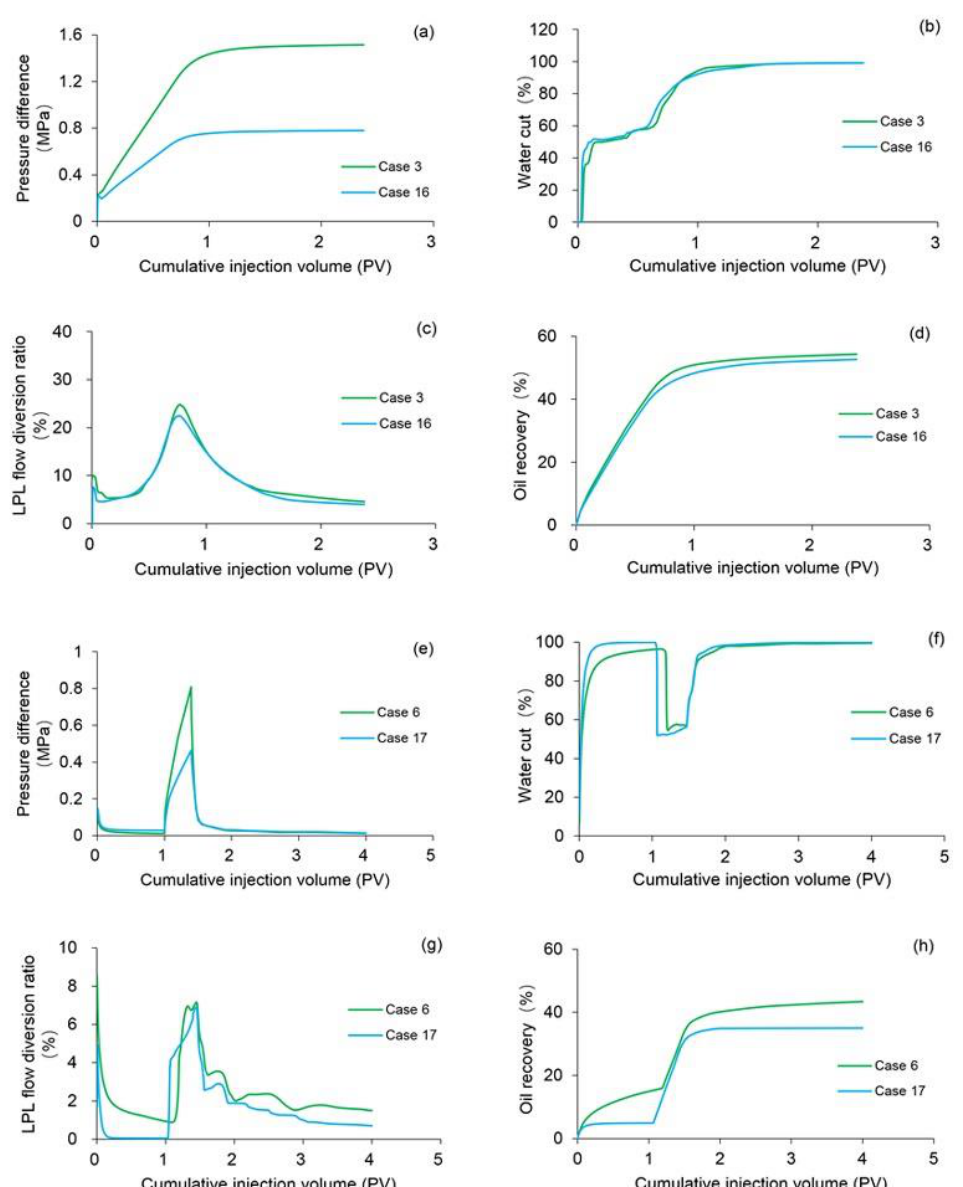
Figure 19. Comparison results of ( a ) pressure difference, ( b ) water cut, ( c ) LPL flow diversion ratio and ( d ) oil recovery of Cases 3 and 16, and those of ( e ) pressure difference, ( f ) water cut, ( g ) LPL flow diversion ratio and ( h ) oil recovery of Cases 6 and 17.